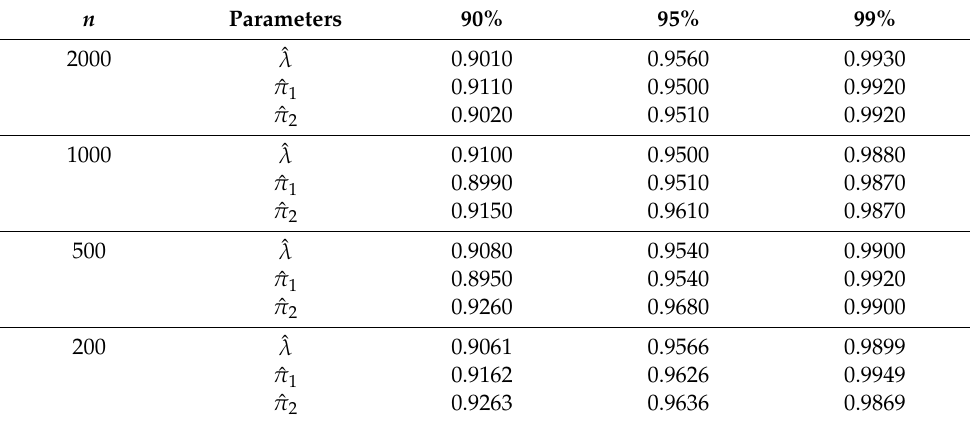
Table 9. Comparison of coverage probabilities of the simulated data. True values λ = 5, π 1 = 0.4, π 2 = 0.1, and k =